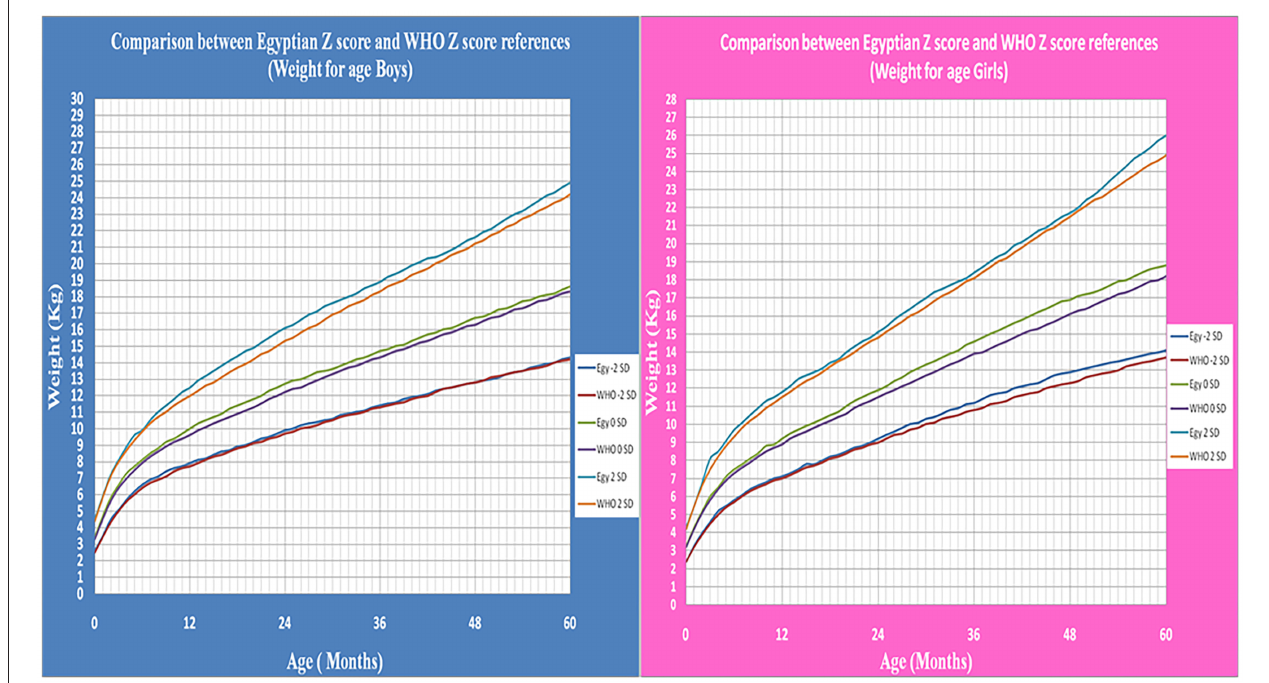
FIGURE 8 | The comparison between Egyptian Z score and WHO Z score references value from birth up to 5 years (weight for age in boys & girls).